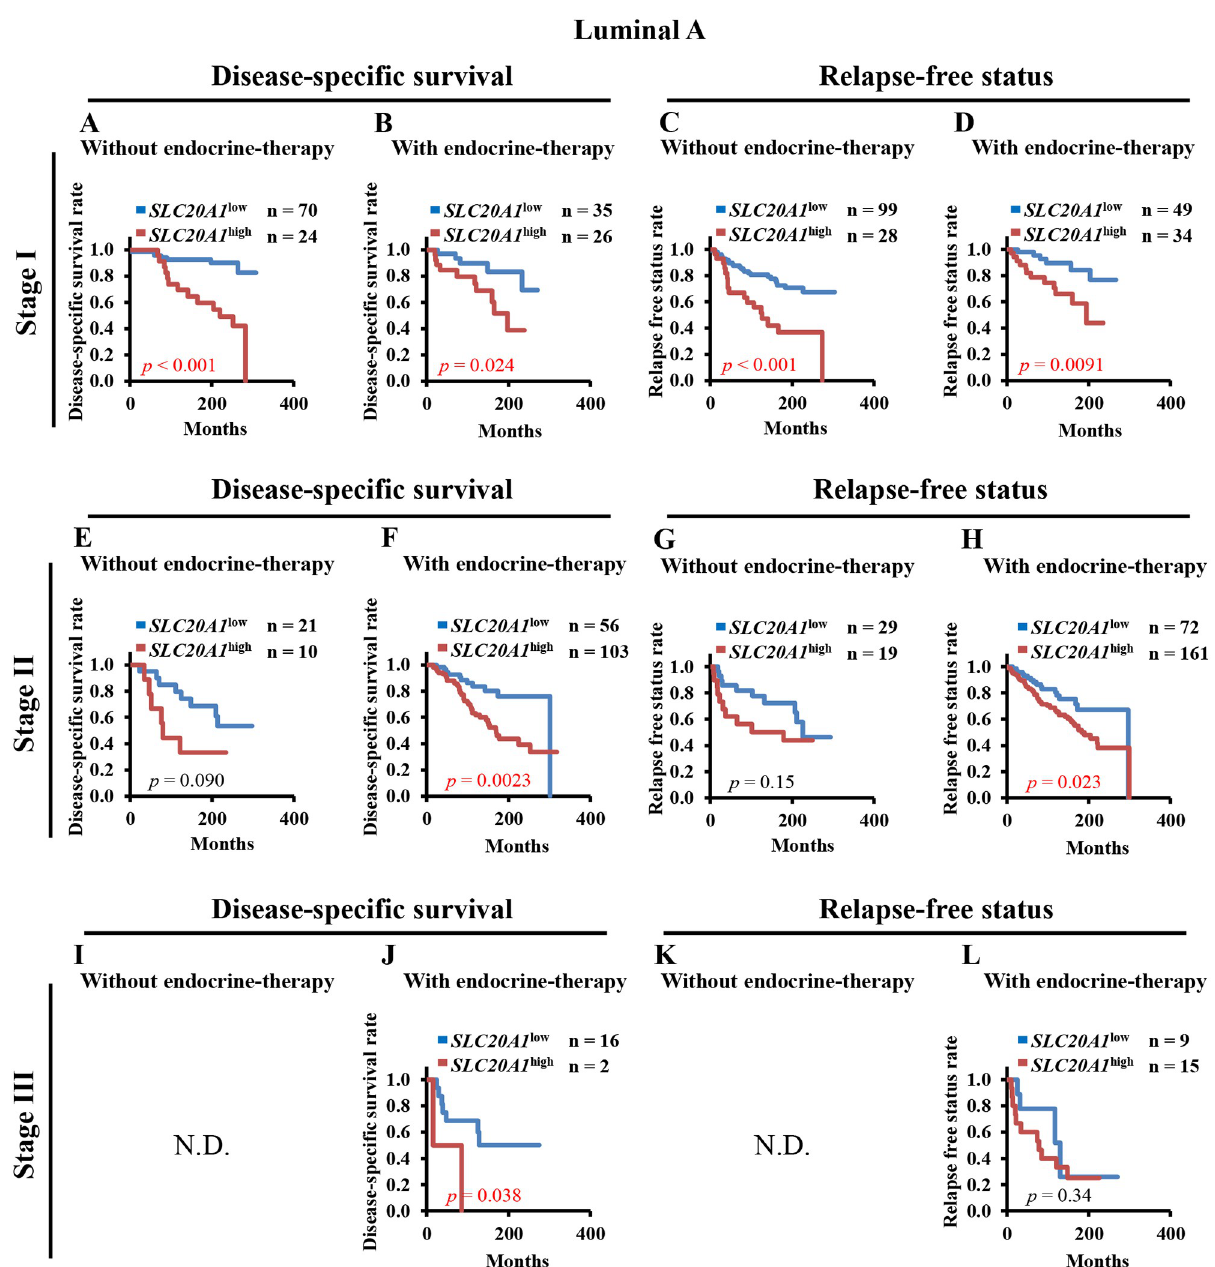
Fig 4. High solute carrier family 20 member 1 (SLC20A1) expression ( SLC20A1 high ) confer poorer clinical outcomes in patients with luminal A breast cancer at the early stages with endocrine therapy. (A-D) Kaplan-Meier analyses comparing disease-specific survival (DSS) or relapse-free status (RFS) between the SLC20A1 high and low SLC20A1 expression ( SLC20A1 low ) groups amongst patients with stage I luminal A breast cancer without or with endocrine therapy. (A) Comparing DSS of patients without endocrine therapy. (B) Comparing DSS of patients with endocrine therapy. (C) Comparing RFS of patients without endocrine therapy. (D) Comparing RFS of patients with endocrine therapy. (E-H) Kaplan-Meier analyses comparing DSS or RFS between the SLC20A1 high and SLC20A1 low groups amongst patients with stage II luminal A breast cancer without or with endocrine therapy. (E) Comparing DSS of patients without endocrine therapy, (F) Comparing DSS of patients with endocrine therapy, (G) Comparing RFS of patients without endocrine therapy, (H) Comparing RFS of patients with endocrine therapy. (I-L) Kaplan-Meier analyses comparing DSS or RFS between the SLC20A1 high and SLC20A1 low groups amongst patients with stage III luminal A breast cancer without or with endocrine therapy. (I) Comparing DSS of patients without endocrine therapy. (J) Comparing DSS of patients with endocrine therapy. (K) Comparing RFS of patients without endocrine therapy. (L) Comparing RFS of patients with endocrine therapy. (I and K) There were insufficient numbers for Kaplan-Meier analysis. N.D. stands for “not determined”.